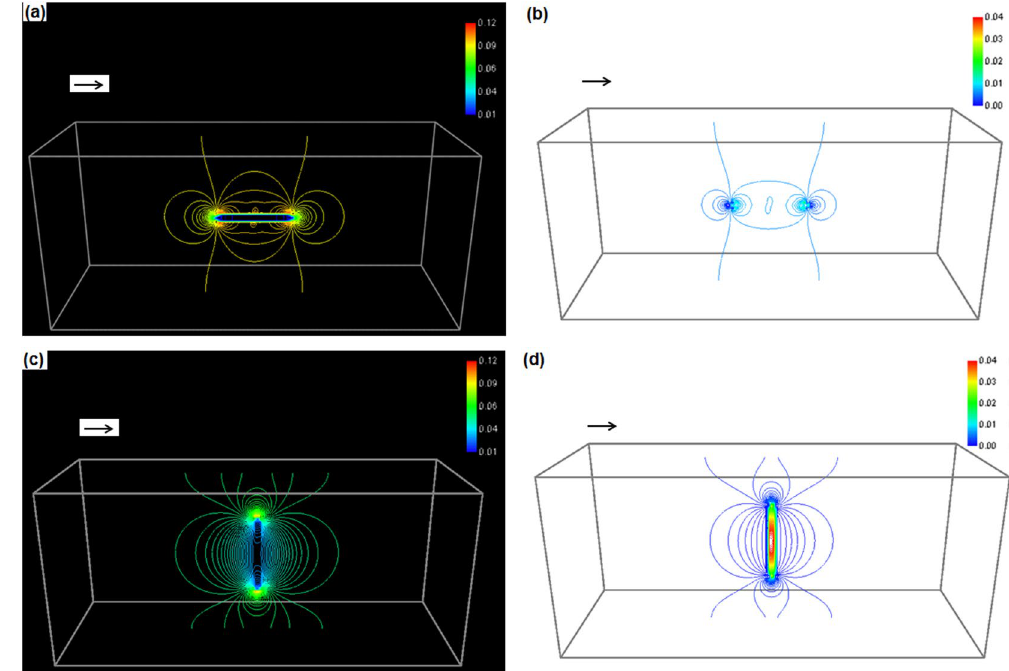
Figure 5. Distribution of apparent electric current density (( a ) and ( c )) and apparent Ohm-heat-induced temperature (( b ) and ( d )), where ( a ) and ( b ) are with incline angle θ = 0°; ( c ) and ( d ) are with incline angle θ = 90°. The arrows in the figure represent the applied electric field.